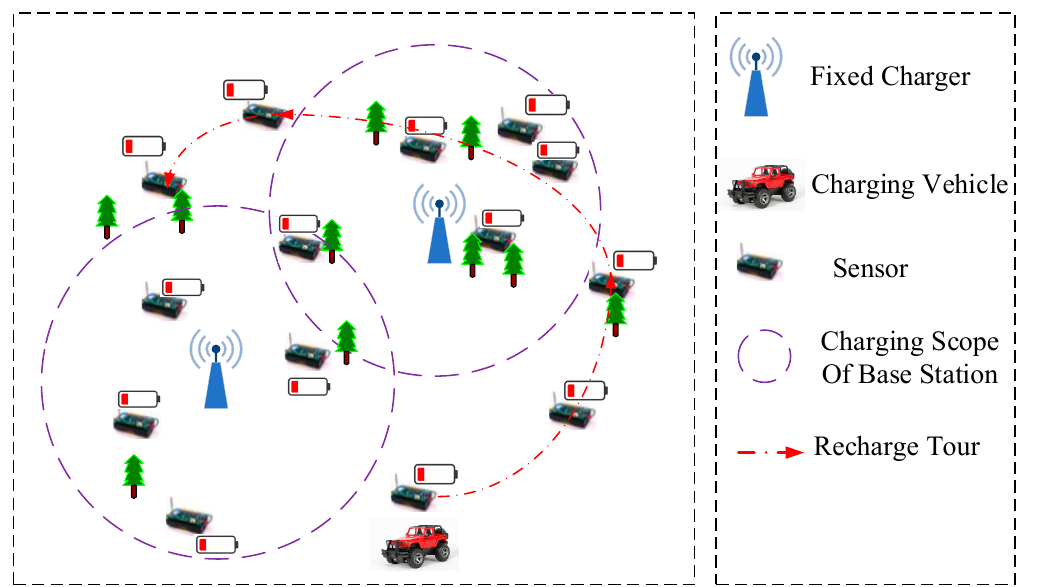
Figure 1. Illustration of the network architecture and components. Table 1. Parameters.